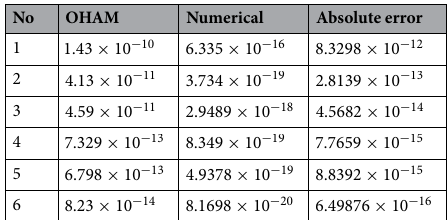
Table 4. HAM and Numerical comparison for Fe 3 O 4 : when φ Fe 3 O 4 = φ Cu = 0.02,Pr = 6.2, Re ω = 0.3, Re � = 0.13.